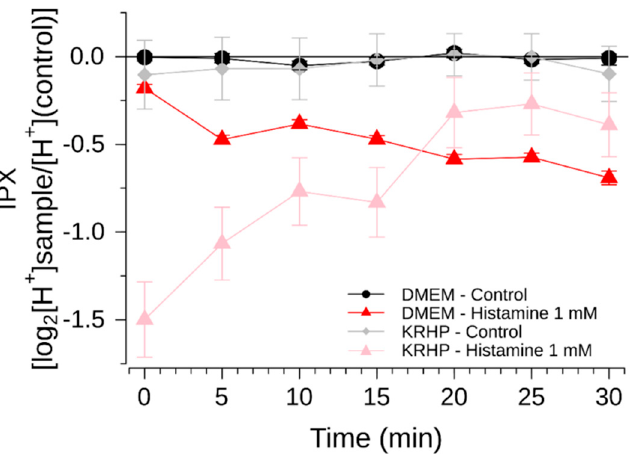
Figure 3. Intracellular proton index (IPX) of HGT-1 cells exposed to 1000 µM histamine under DMEM (red triangle) and under KRHP (pink triangle). Recordings were performed at room temperature at intervals of 5 min. Cells treated with vehicle solution served as negative control for both groups (gray diamonds and black circles). Data presented as mean ± SEM. N of 6 BR.